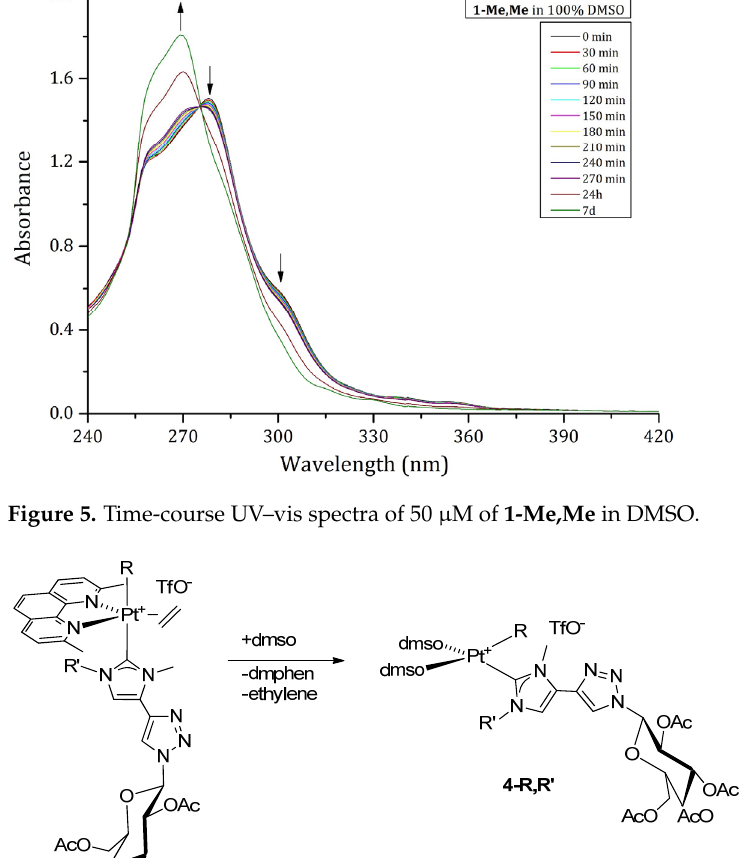
Figure 6. The 1 H NMR spectrum of 1 ‐ Me,Oct in DMSO ‐ d 6 after dissolution (bottom), 1.5, 5, and 24 h (up). Attempts to evaluate their stability in aqueous solutions were complicated due the poor solubility of the complexes in water. Only for 1 ‐ Me,Me was it possible to prepare a solution in the mixed solvent D 2 O:DMSO ‐ d 6 10:1. After 24 h, no appreciable changes in the NMR spectra of the complex were observed (Figure S17). To further study the stability of 1 ‐ Me,Me in aqueous solvents, UV–vis absorption spectra over time were collected under the two experimental conditions (20% ethylene glycol, 0.1 M sodium acetate buffer 0.00.51.01.52.02.53.03.54.04.55.05.56.06.57.07.58.08.59.09.5 ppm